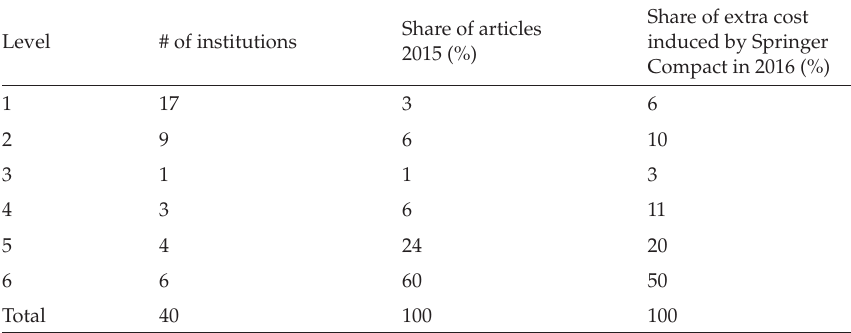
Table 5. The original number of institutions on the different levels and their share of the articles in 2015 and extra cost in